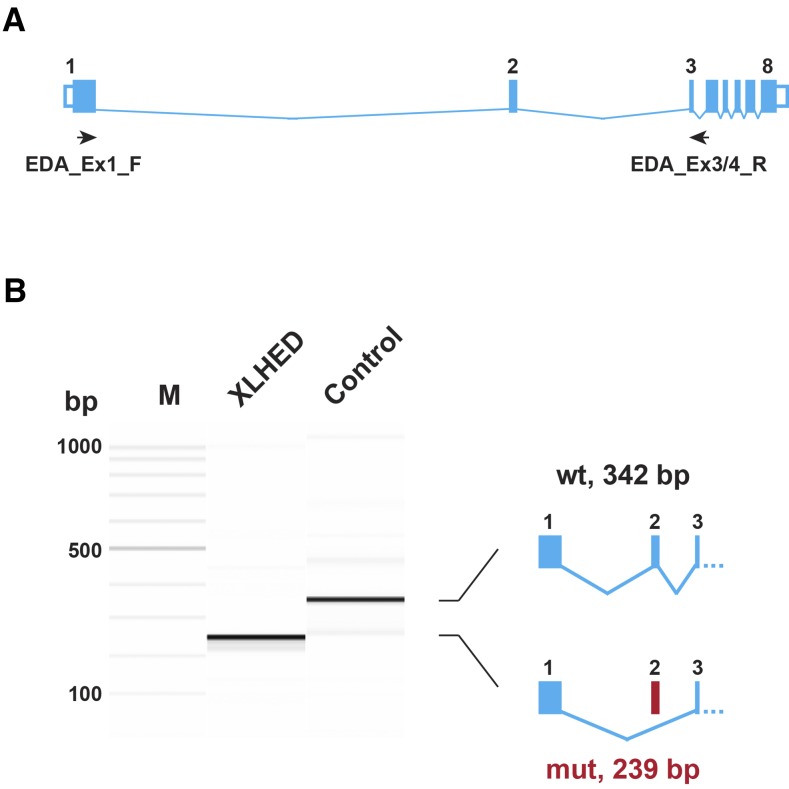
RT-PCR confirmation of the splice defect. (A) Genomic organization of the canine EDA gene with its eight exons. The positions of a forward primer in exon 1, and a reverse primer at the boundary of exon 3 and exon 4, for the RT-PCR experiment are indicated. (B) RT-PCR was performed using RNA from skin biopsies of an XLHED-affected and a control dog. The picture shows a Fragment Analyzer gel image of the experiment. In the control animal, the expected 342 bp band is visible. In the XLHED-affected dog, the experiment resulted in a 239-bp band corresponding to a transcript lacking exon 2. The identity of the bands was confirmed by Sanger sequencing (Figure S1).